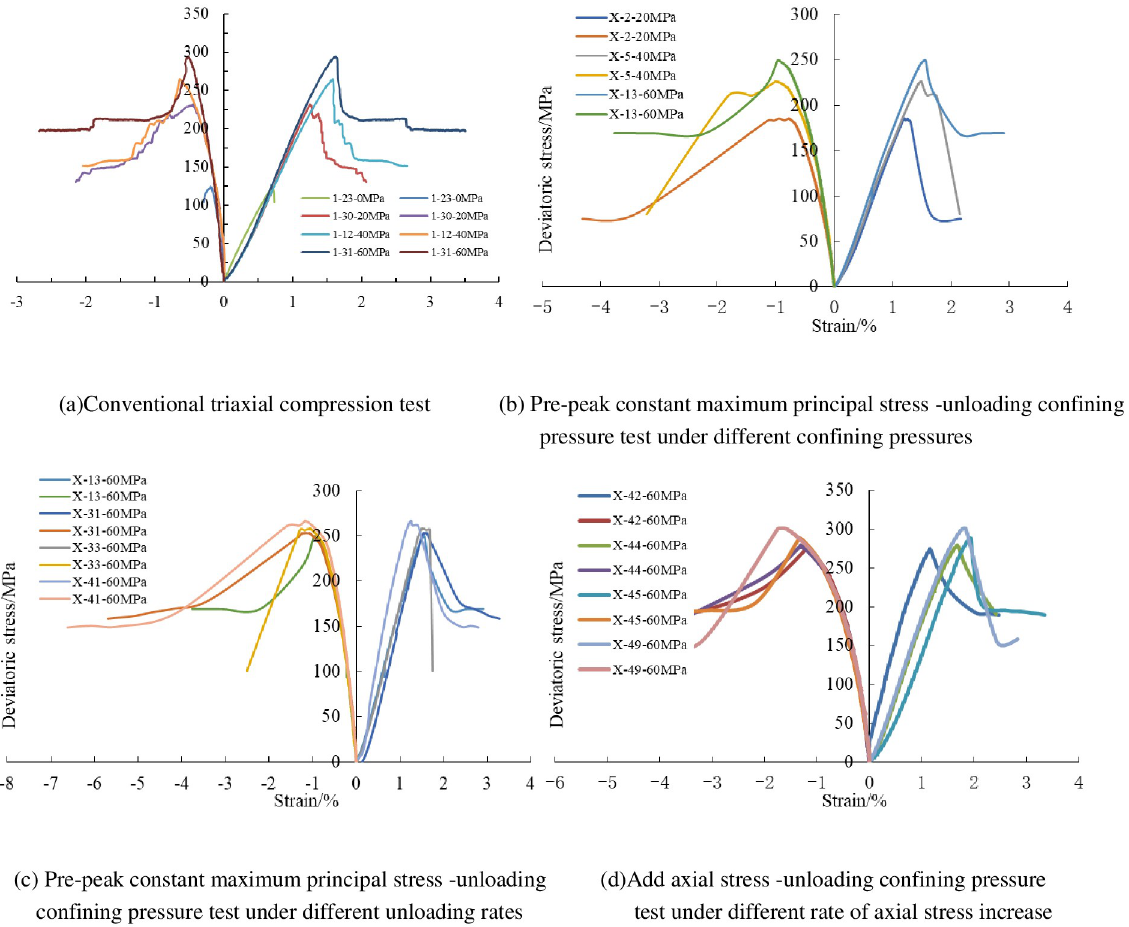
Fig 2. Typical complete stress-strain curves of shale rock under different stress